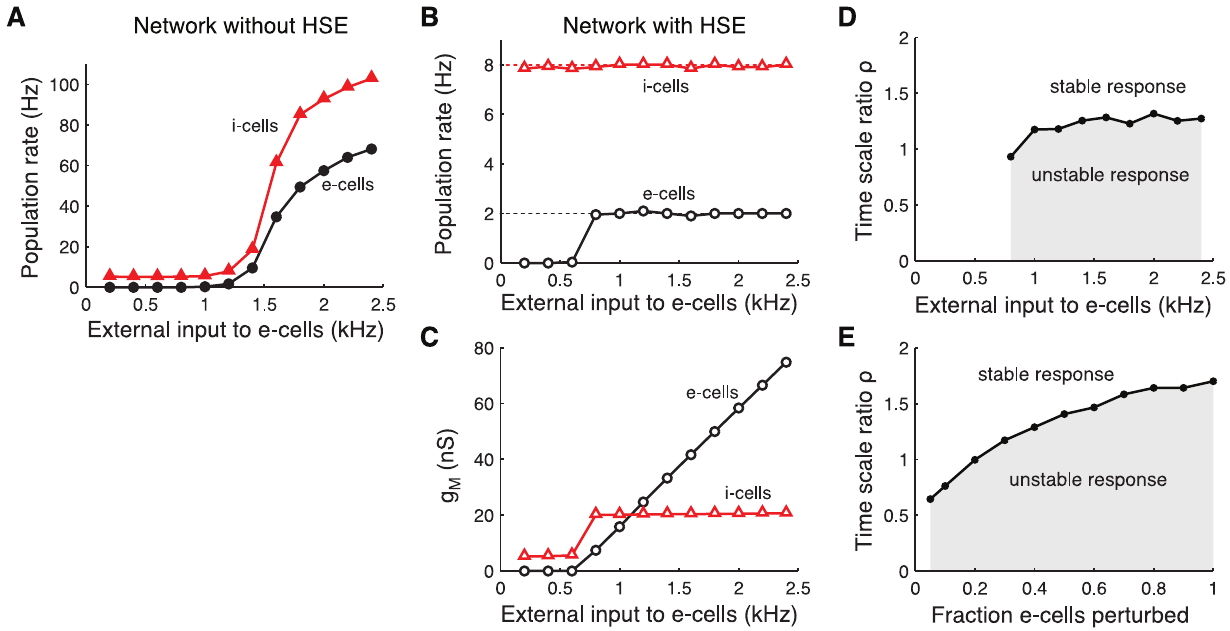
Figure 6. Adapting to persistent changes in the external drive to excitatory cells. Steady state response of the recurrent network when the compound external excitatory drive to the e-cells ranges from 0.2 to 2.4 kHz, while the external drive to the i-cells is constant at 1.2 kHz. A: Median firing rate of e-cells (circles) and i-cells (triangles) in the network without HSE. B: Median firing rate of e-cells (circles) and i-cells (triangles) in the network with HSE. Dotted lines at 2 and 8 Hz give target rates of both cell types. C: Population mean g M of e-cells (circles) and i-cells (triangles) in the network with HSE. D: Required ratio of adaptation time scales r for stable adaptation dynamics when the network is perturbed from its adapted state (characterized in panels B and C). The perturbation consists of a 0.1 kHz step increase of the external drive to the e-cells. The same criterium for stability of the adaptation dynamics is used as in figure 2. E: As in D, except that a perturbation of 0.3 kHz is applied to 5% to 100% of the e-cells. The perturbations are applied to a network that is adapted to a compound external input level of 1.2